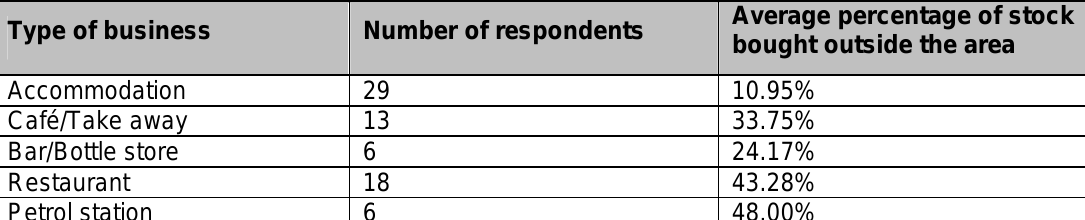
Table 6: Average leakages according to business type Type of business Number of respondents